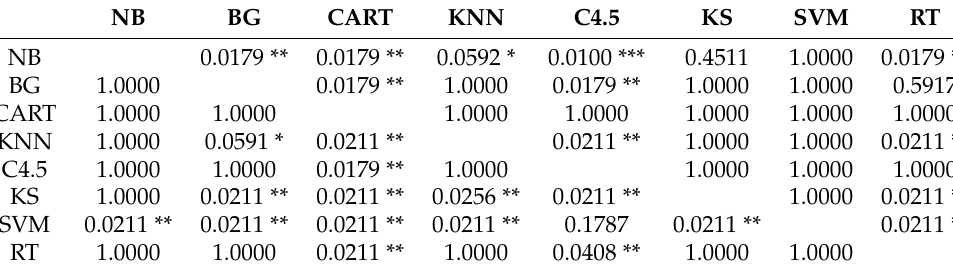
Table 11. Pairwise WSR test for F1-measure of